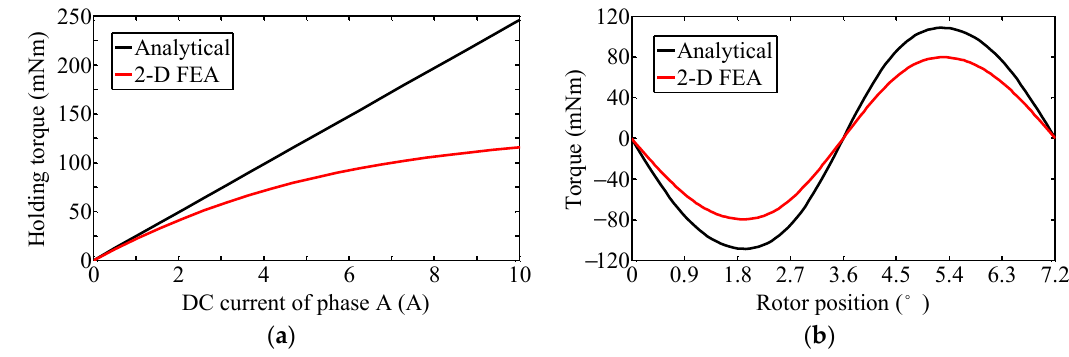
Figure 20. Comparison of torque properties by analytical method and 2-D FEA. ( a ) Holding torque property of sub-motor1; ( b ) Torque-angle property of sub-motor1 with rated current excitation.